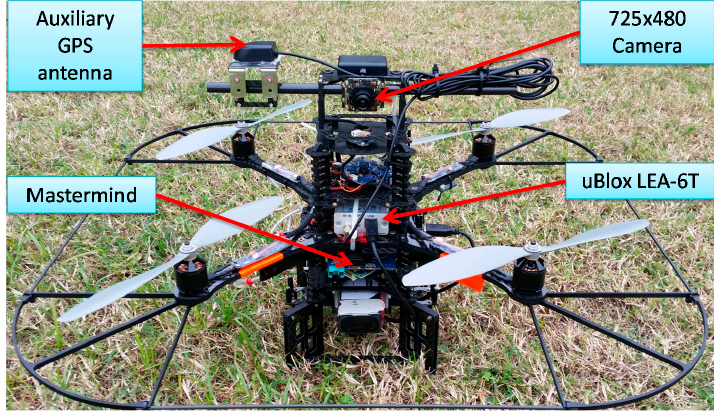
Figure 6. Chief vehicle (Customized Ascending Technologies TM Pelican). Table 2. Pelican Navigation